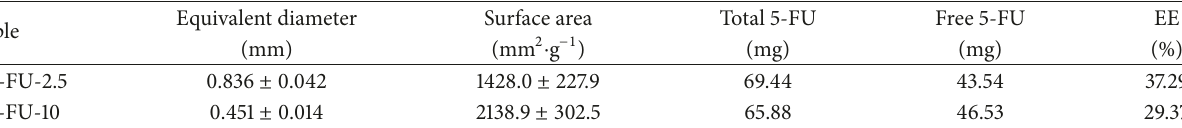
Table 3: 5-FU encapsulation efficiency data.